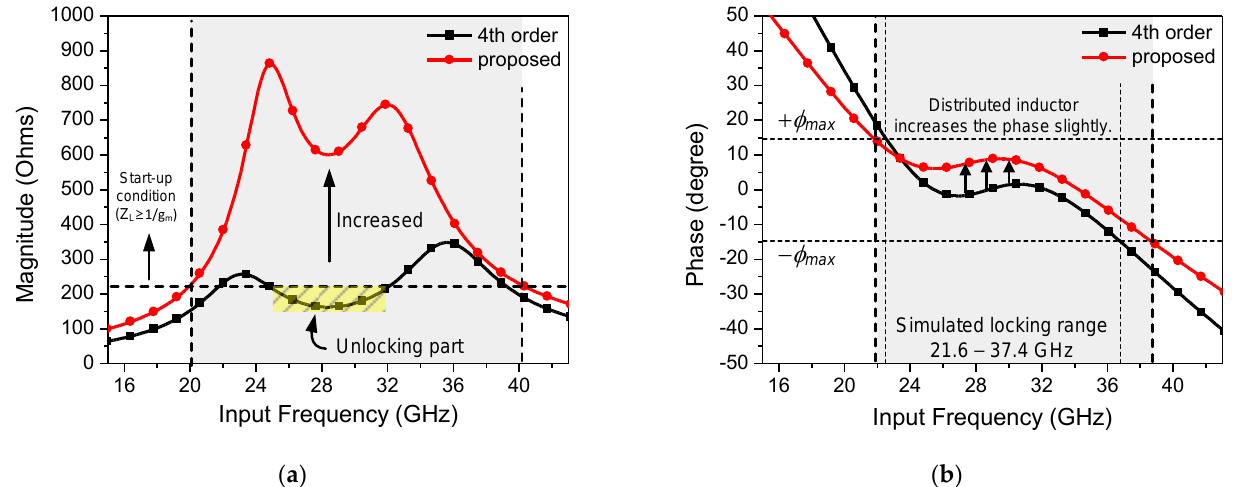
Figure 7. ( a ) Simulated magnitude plot and ( b ) phase plot of the fourth-order resonator-based ILFD and proposed CR-